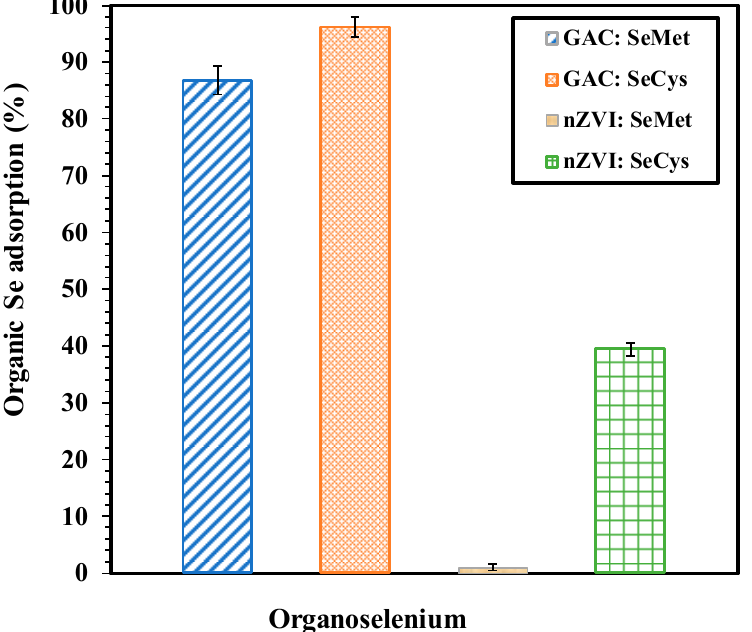
Figure 2. Comparison of organic selenium removal using 7 g/L of GAC and nZVI, pH 7.0, at 25 °C for 3 h period.